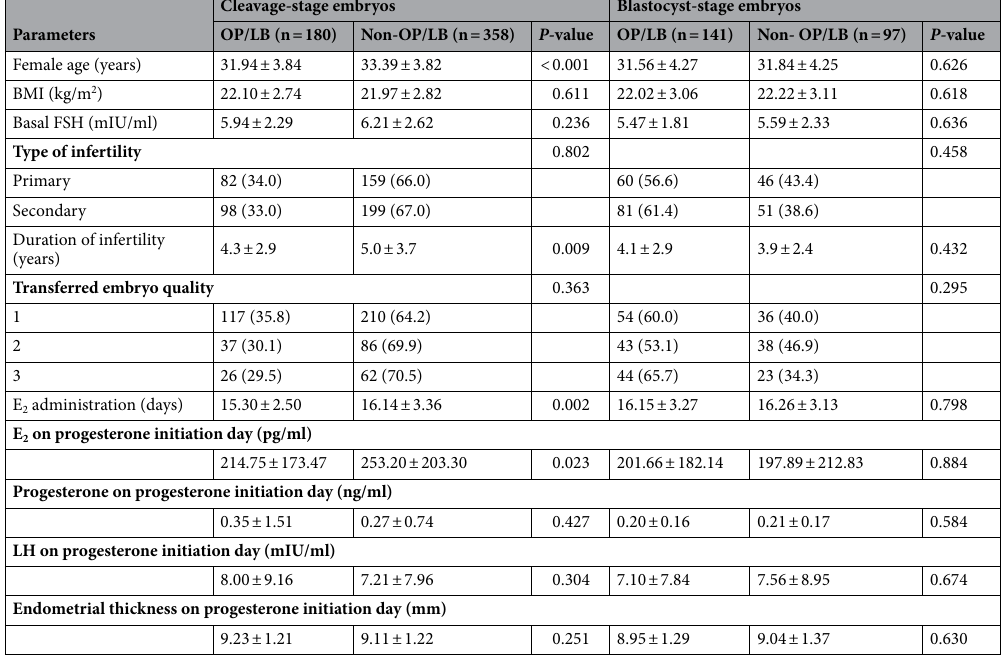
Table 1. Demographic details between OP/LB women and non-OP/LB women. Data are presented as mean ± standard deviation or n (%). OP/LB ongoing pregnancy/live birth, BMI body mass index, FSH follicle stimulating hormone, E 2 estradiol, LH luteal hormone.